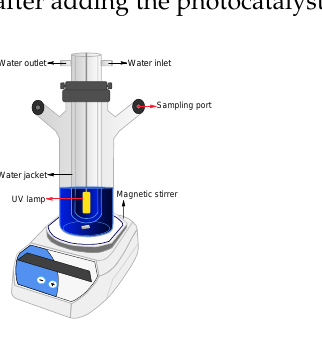
Figure 2. Photocatalytic reaction setup for MB degradation using ZnO – Ag nanocomposite.